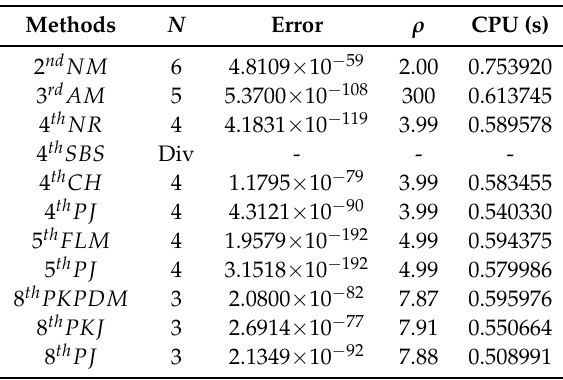
Table 7. Comparison of results for Application 4.